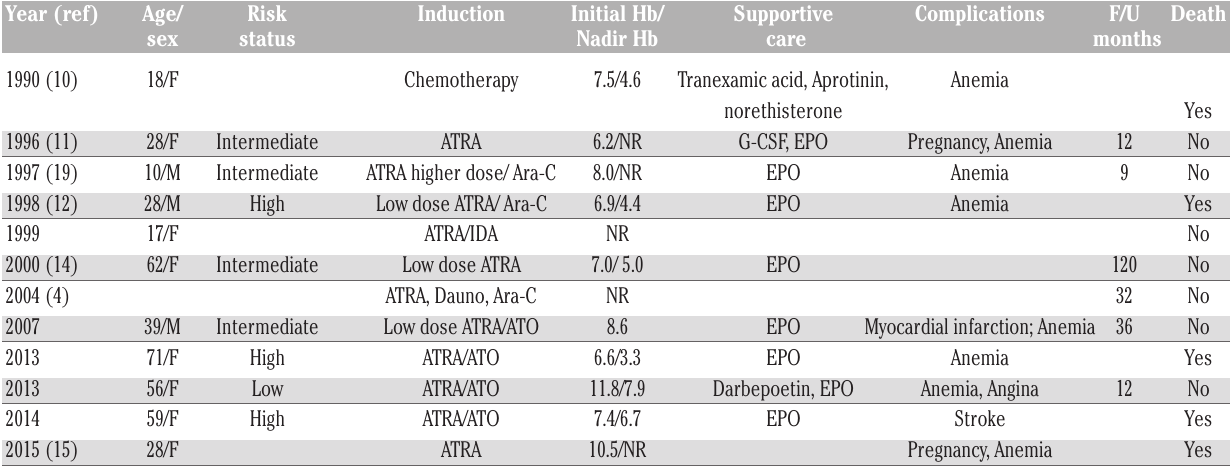
Table 1. Induction of acute promyelocytic leukemia patients belonging to the Jehovah’s witness congregation.